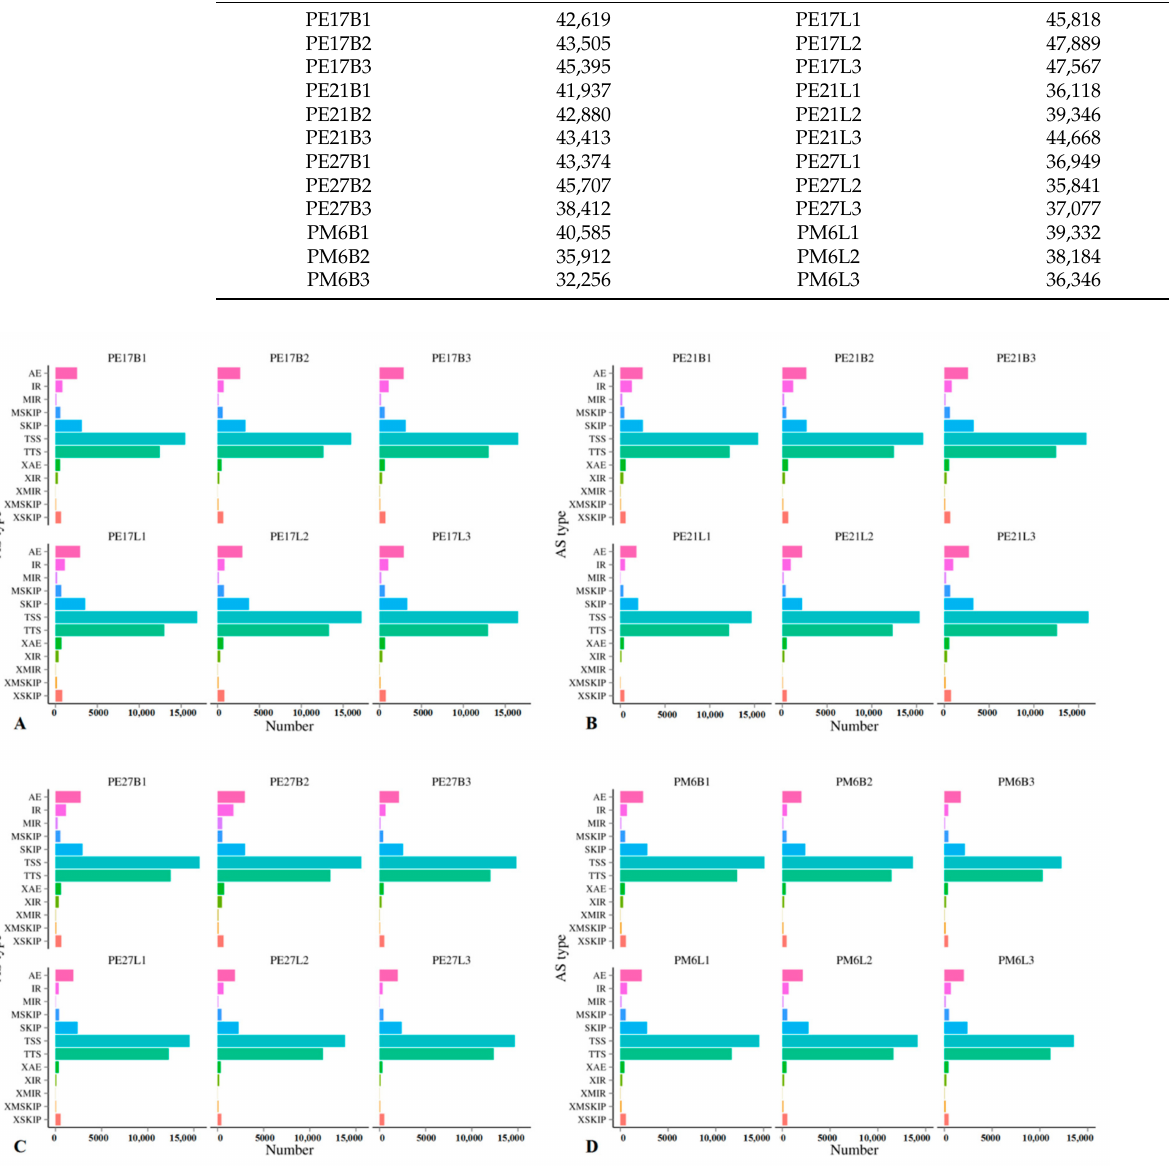
Figure 2. The predicted number of alternative splicing in Pekin ducks during different incubation stages. ( A – D ) represent the predicted number of alternative splicing in E17d, E21d, E27d and M6,